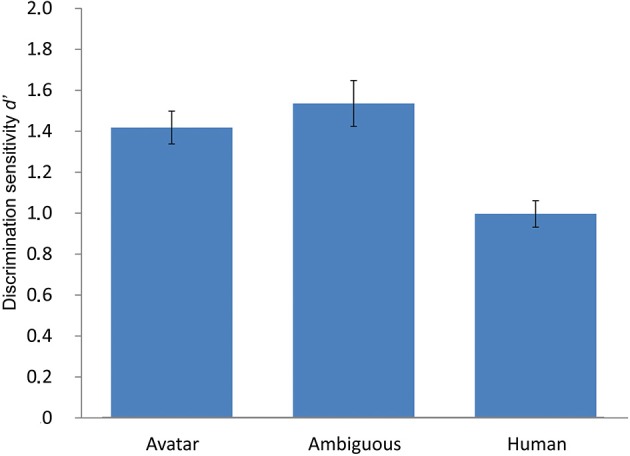
Results of the ABX perceptual discrimination task. The figure depicts mean discrimination sensitivity d′ in the ABX perceptual discrimination task for unambiguous avatar and human and highly ambiguously faces. The profile of discrimination sensitivity replicates that found in the first experiment. Perceptual discrimination difficulty is greatest for human faces. The error bars indicate 1 SE (N = 49).